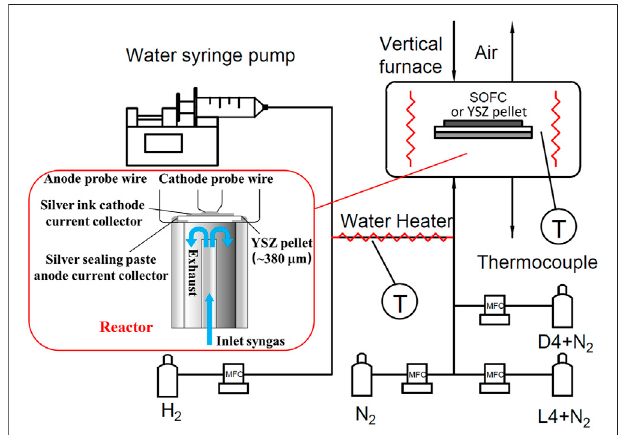
FIGURE 1 | Schematic of experiment